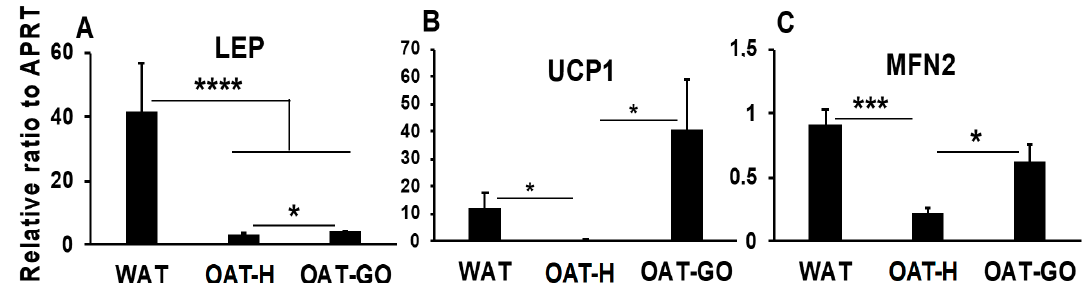
Figure 2. OAT is neither WAT nor brown adipose tissue (BAT)/BRown-in-whITE (BRITE). ( A – C ), QPCR analysis of OAT-H ( n = 4), OAT-GO ( n = 9) and WAT ( n = 6) ex vivo fat. LEP (WAT marker) and UCP1 (BAT/BRITE marker) were analyzed using the relative ratio of gene expression by QPCR, and housekeeper gene APRT served as the reference gene. MFN2 (mitochondrial/BAT/BRITE marker) was analyzed by standard PCR, densitometry was measured and corrected to the house-keeping gene ( APRT ), MFN2 expression relative to APRT is presented. Histograms = mean ± SEM of all samples studied. * p < 0.05; *** p ≤ 0.005, **** p ≤ 0.0006.